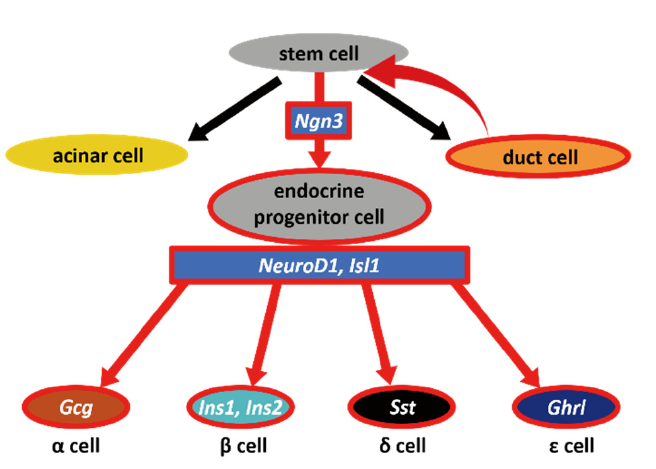
Figure 5. Schematic diagram of our hypothesis. In vivo and in vitro results indicated that dedifferen- tiation occurs in the pancreatic duct when ducts are severely injured. As a result, Ngn3-positive cells emerge from pancreatic stem cells; these stem cells have the potential to become mature endocrine cells, acinar cells, as well as duct